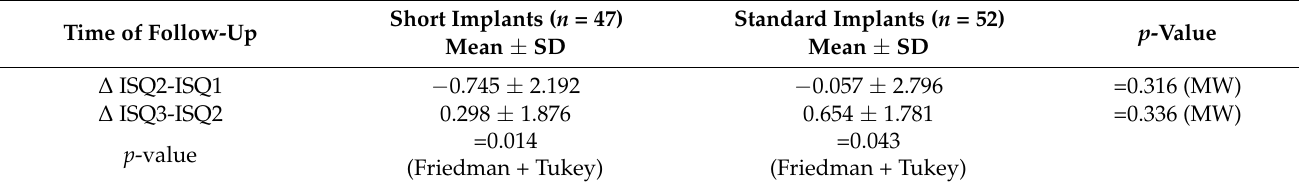
Table 2. Comparison of ISQ increases between short and standard implants at the three follow-up time points.